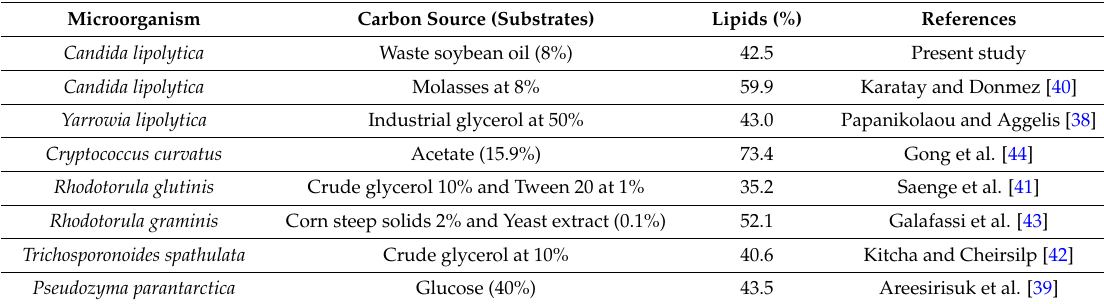
Table 5. Comparison of lipid production by yeasts using different substrates with Candida lipolytica UCP 0988 in this